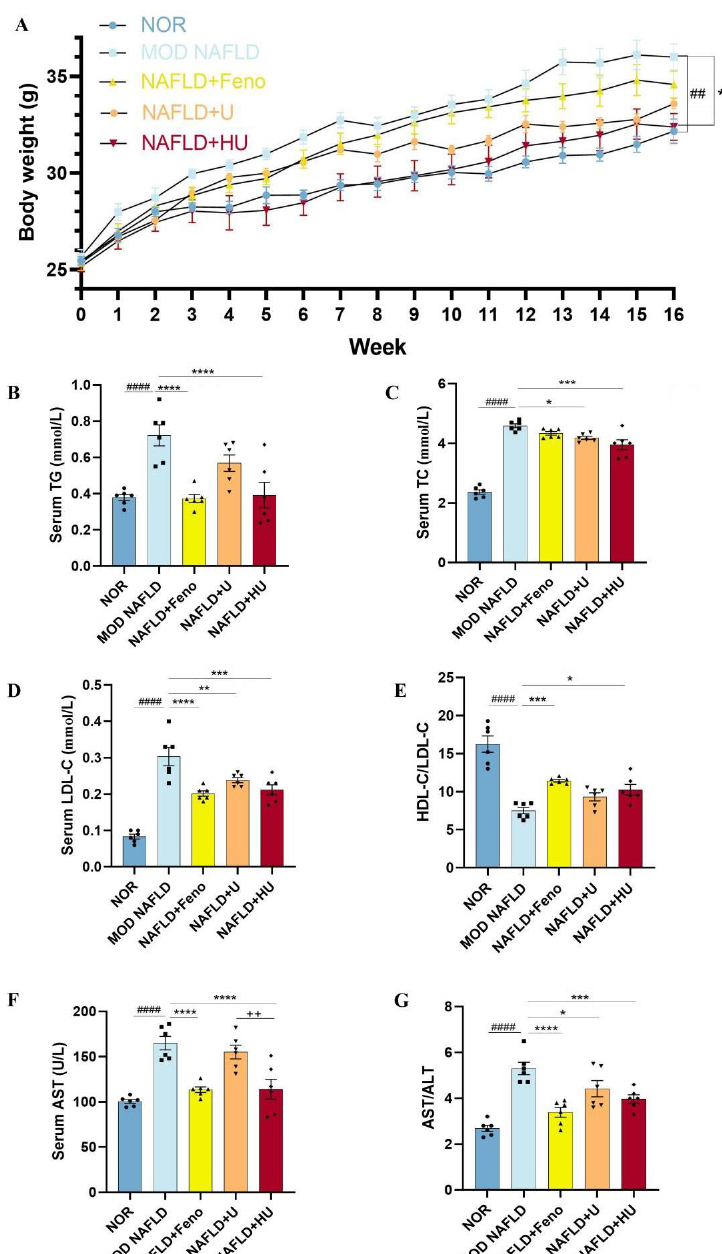
Figure 7. Effects of U and HU on body weight, lipid metabolism indicators, and liver function in NAFLD mice. ( A ) Weight change over time. Results of blood parameters: ( B ) TG, ( C ) TC, ( D ) LDL-C, ( E ) HDL-C and LDL-C ratio, ( F ) ALT, ( G ) AST and ALT ratio. Data are shown as the mean ± SEM. ## p < 0.01, #### p < 0.01 vs. NOR group; * p < 0.05, ** p < 0.01, *** p < 0.005, **** p < 0.0001 vs. MOD group; ++ p < 0.01 vs. U